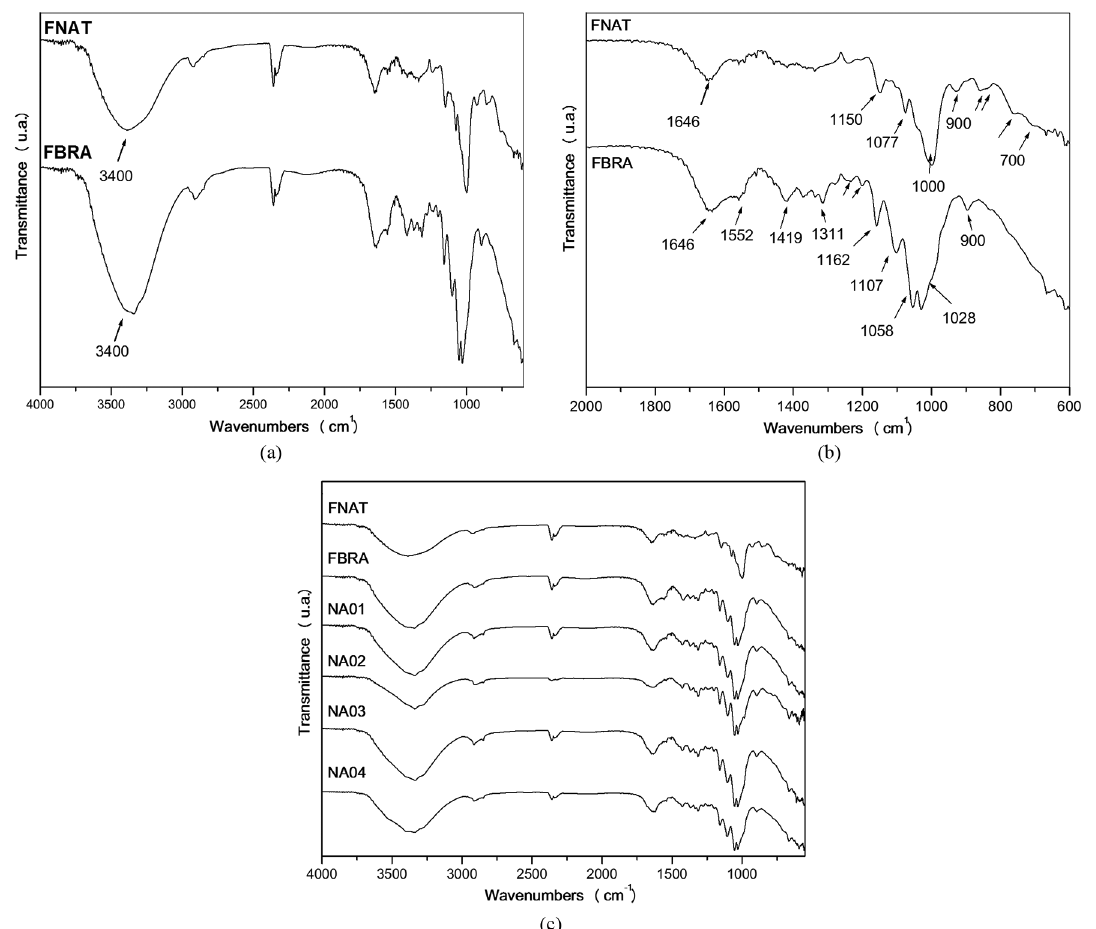
Figure 3. FTIR spectra of in nature , bleached fibers and of the